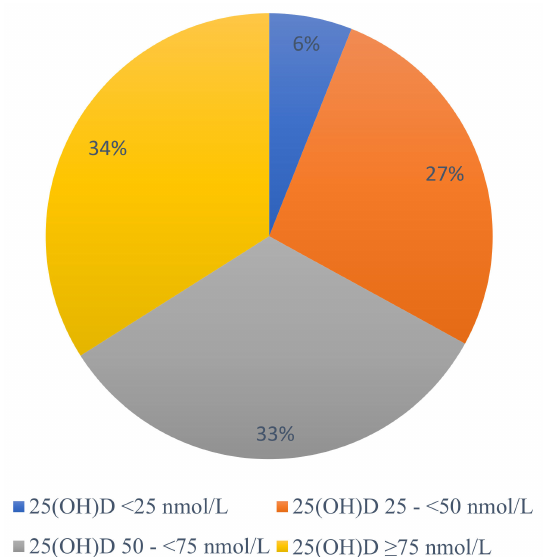
Figure 2. Distribution of vitamin D status. 25(OH)D, 25-Hydroxyvitamin